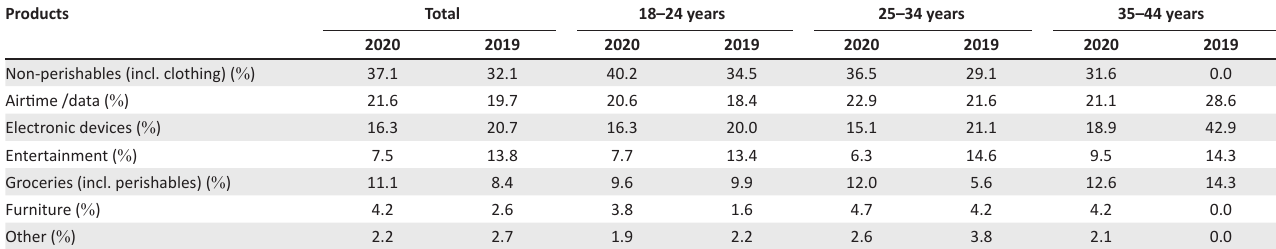
TABLE 2: Online shopping products.